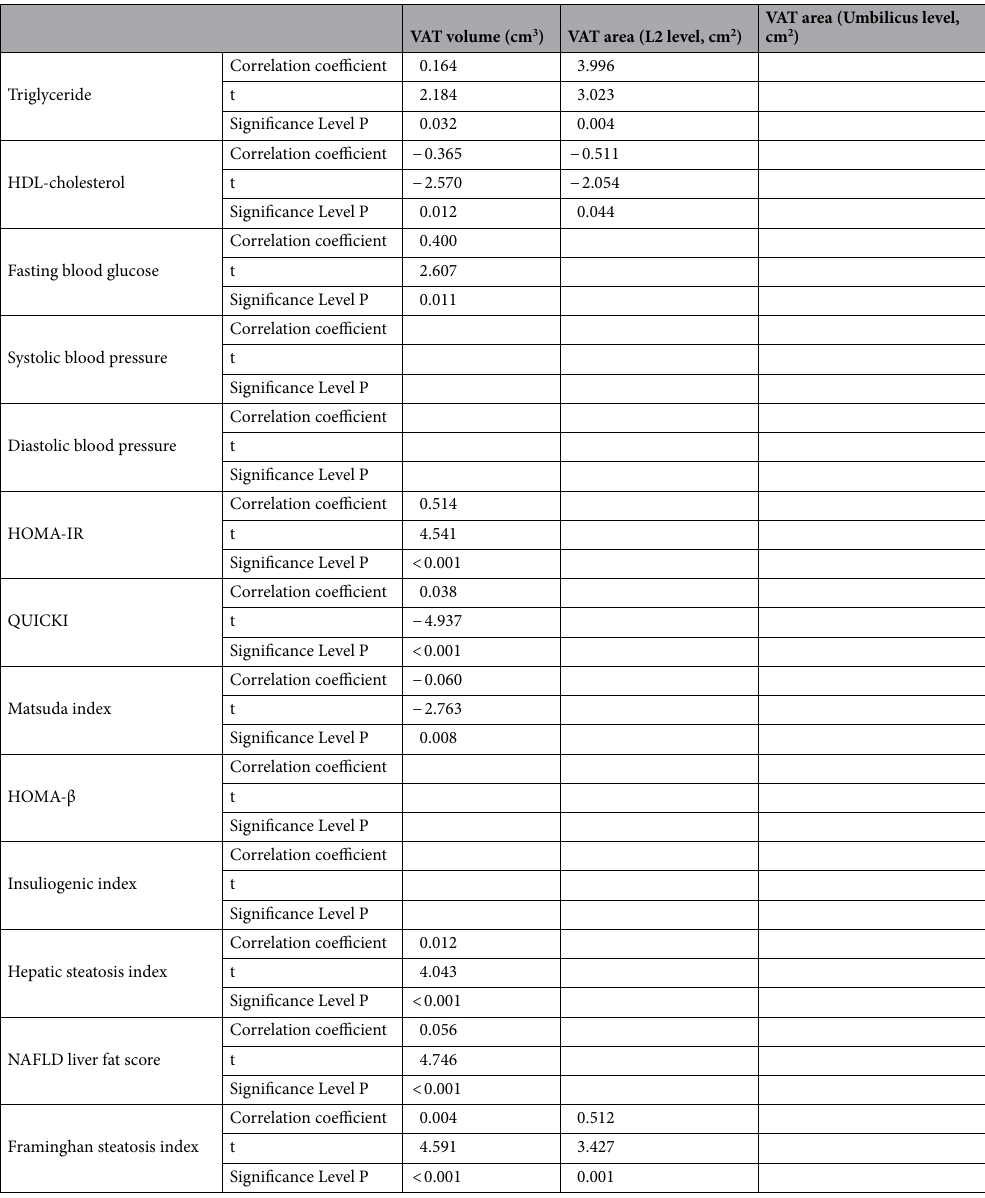
Table 3. Multivariable regression analysis between VAT measurement methods to metabolic risk factors. VAT, visceral adipose fat tissue; HDL, high-density lipoprotein; HOMA-IR, homeostatic model assessment of insulin resistance, HOMA-β, homeostatic model assessment of β-cell function; QUICKI, quantitative insulin sensitivity check index; NAFLD, nonalcoholic fatty liver